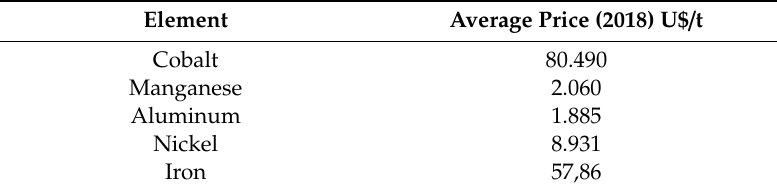
Table 1. Average value of some metals at year-end 2018. Source: https: // www.metalary.com / ,